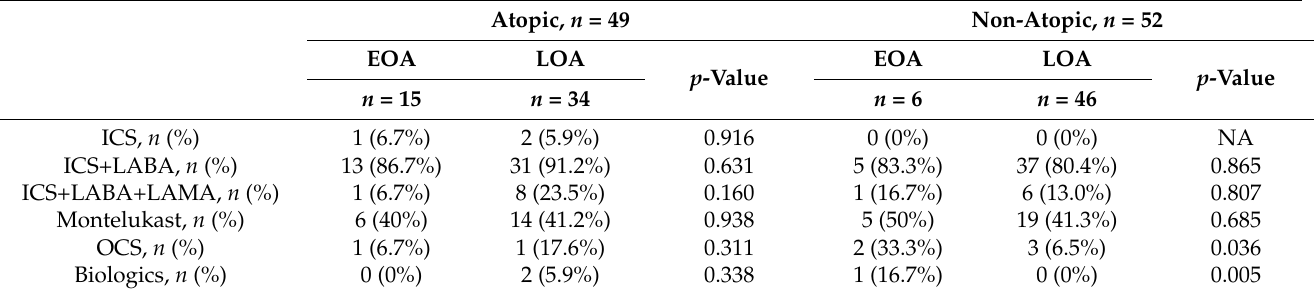
Table 3. The treatment for patients with